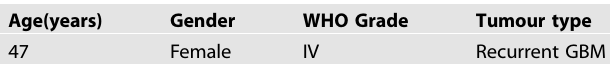
(Fig. S2 Table 1). Brie fl y, tumour tissue was minced (by crossed scalpels) in DMEM cell culture medium supplemented with 10 % FCS, EGF, and FGF2,